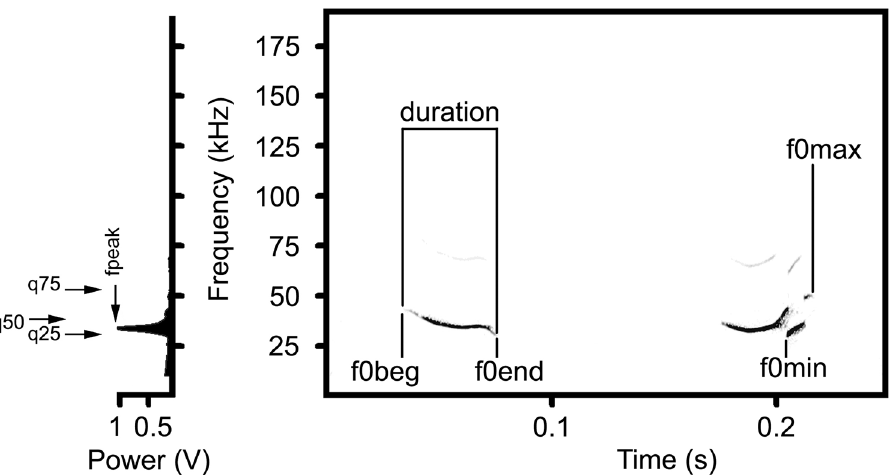
Figure 2. Measured variables for adult yellow steppe lemmings USV calls exemplified by a female USV without frequency jump and by a female USV with frequency jump. Spectrogram (right) and mean power spectrum of the first entire call (left). Designations: duration—call duration; f0beg—the fundamental frequency at the onset of a call; f0end—the fundamental frequency at the end of a call; f0max—the maximum fundamental frequency; f0min—the minimum fundamental frequency; fpeak—the frequency of maximum amplitude; q25—the lower quartile; q50—the medium quartile; q75—the upper quartile. Spectrogram was created using sampling frequency 192 kHz, Hamming window, FFT 1024 points, frame 50% and overlap